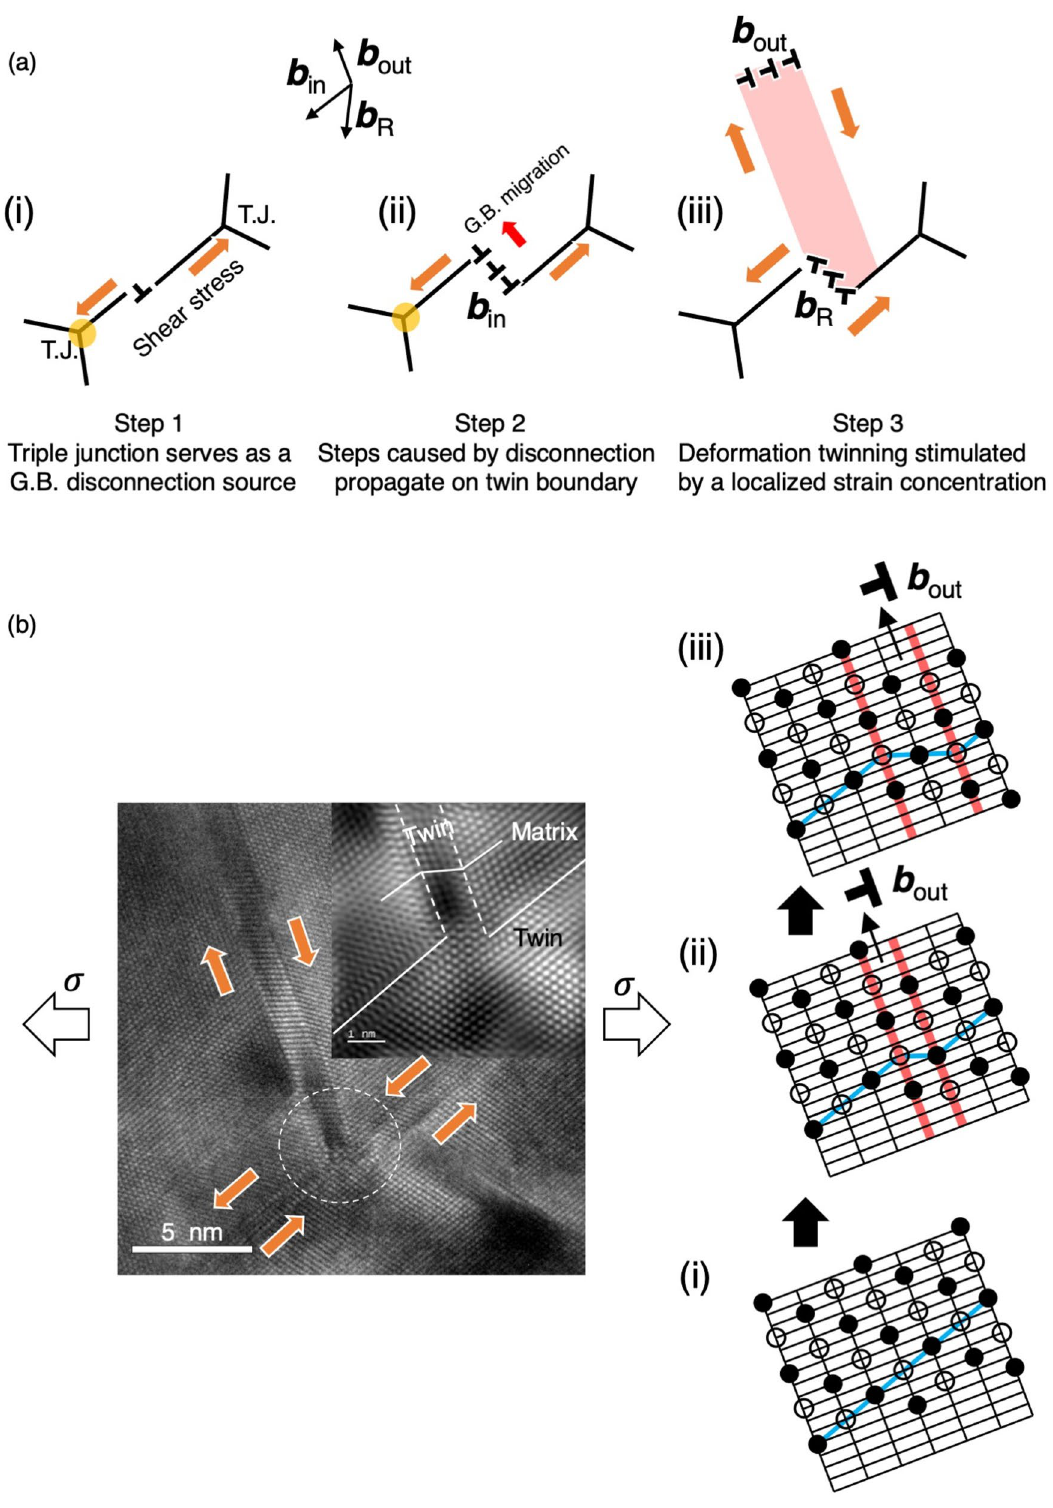
Figure 8. ( a ) A schematic illustration shows a three-step mechanism to form a nucleation site for a deformation twin at an originally coherent Σ3{111} twin boundary. Step 1: Triple junction serving as a source of grain boundary disconnection. Step 2: Steps caused by disconnection propagating on the twin boundary. Step 3: Defective steps containing mixed character twin boundary dislocations generate a localized strain accumulation progressively, thus stimulating the deformation twin nucleation. ( b ) Deformation twinning processes (i to iii) are schematically illustrated. The emission of closely spaced overlapping stacking faults lying on parallel ( 1 1 1 ) planes is demonstrated with a step-by-step